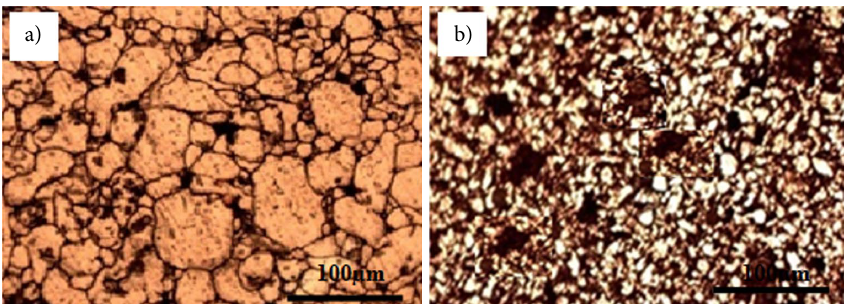
Figure 10. Micrographs images for base alloy (a) and composite reinforced with 5% Al 2 O 3 nanoparticles (b) after